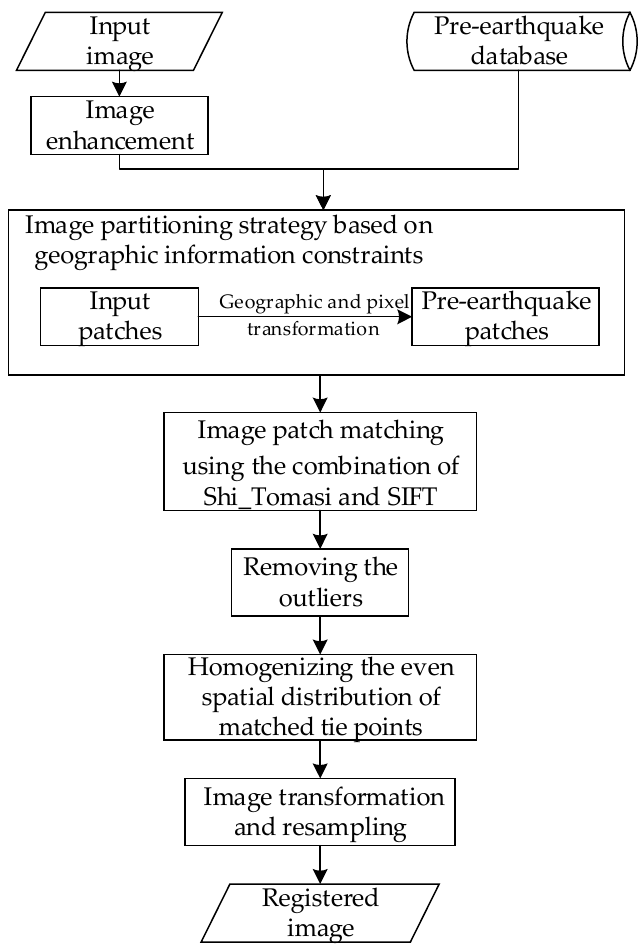
Figure 1. Flowchart of the proposed method. Table 1. The information in the coordinate files of the pre-earthquake remote sensing (RS) image database.